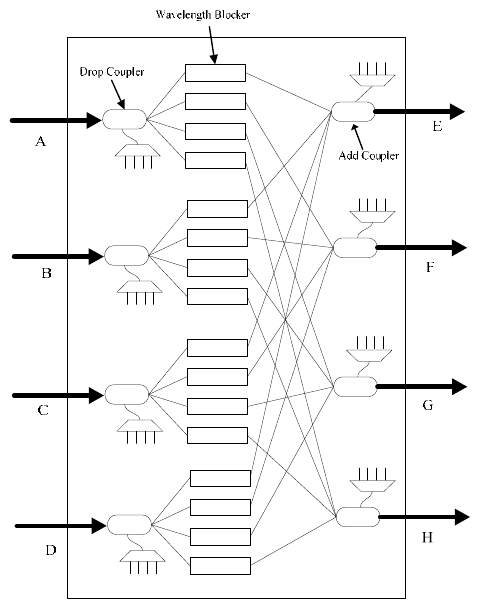
Fig. 2. A node configuration of light-trail for mesh networks ( D =4) Fig. 1 shows the node architecture of light-trails.